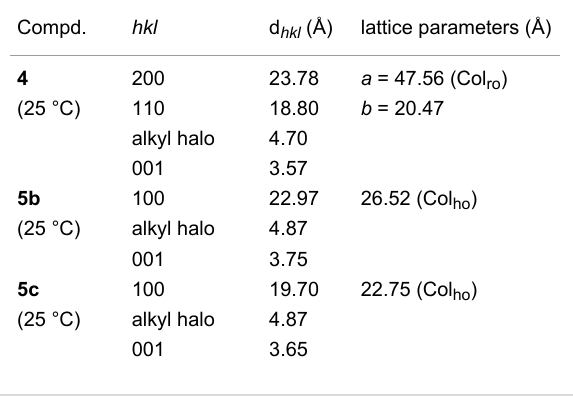
Table 2: Columnar mesophase parameters of the DLC trimers.